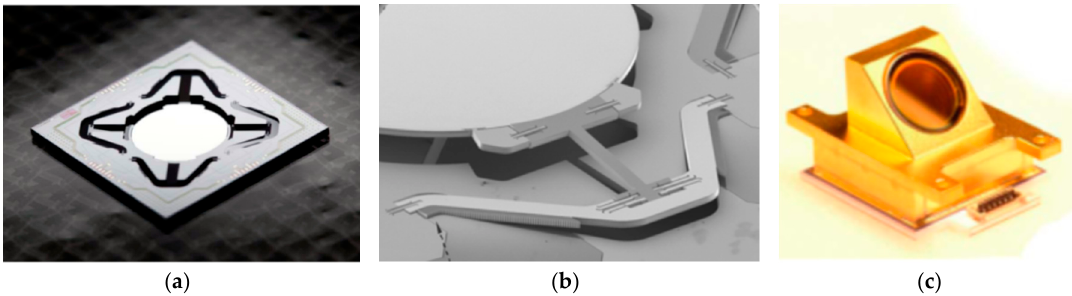
Figure 15. A large displacement vertical electrostatic comb-driven MEMS micromirrors: ( a ) Photograph of new MEMS device at 400 µ m mechanical predeflected; ( b ) modified MEMS design with D = 5 mm and a stroke of 1 mm; ( c ) MEMS vacuum package with ZnSe window. (Reprinted with permission from Reference [38] SPIE).